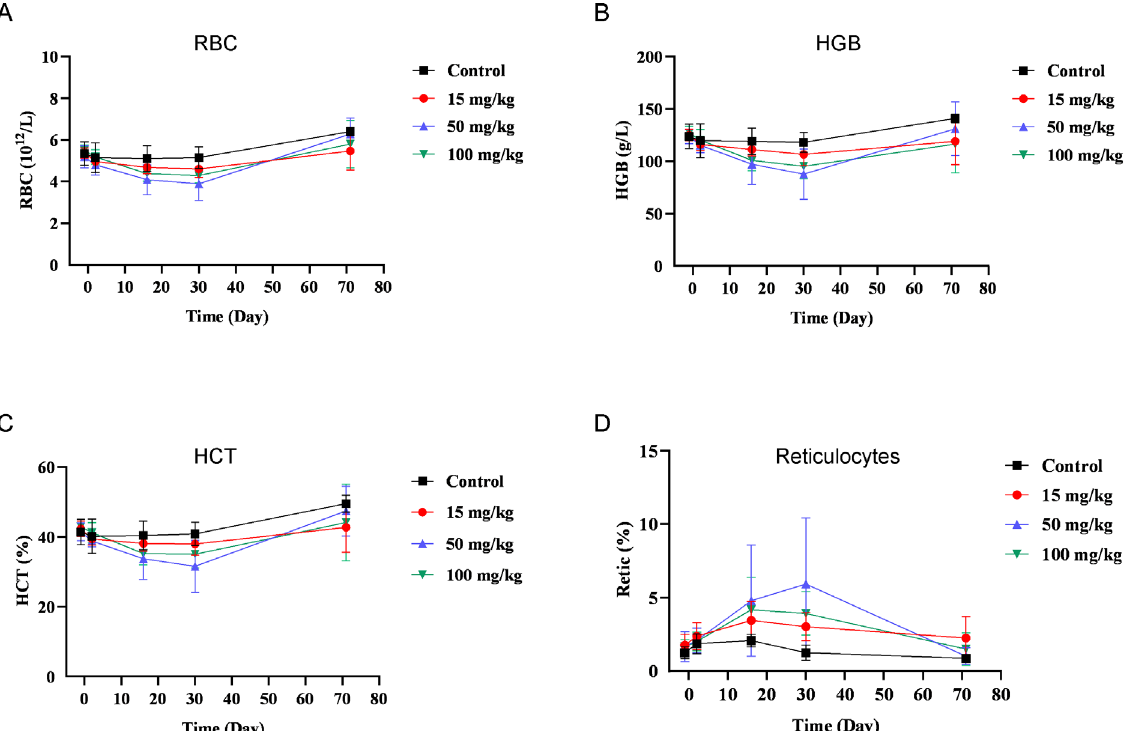
Figure 6. Treatment with BR102 is well tolerated in non-human primates. BR102 was administered to cynomolgus monkeys at 15, 50, and 100 mg/kg (five males and five females for each group) once weekly for a total of 4 weeks. Peripheral blood was collected for hematology during the pre-dose phase; on Days 2 and 16 of the dosing phases; and on Days 30 and 71 of the recovery periods. Hematology parameters, including RBC ( A ), HGB ( B ), HCT ( C ), and reticulocytes ( D ) were measured. Values are presented as mean ± SD.